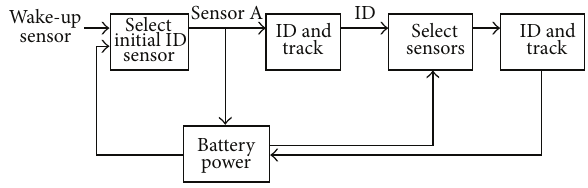
Figure 3: Fuzzy resource allocation technique.